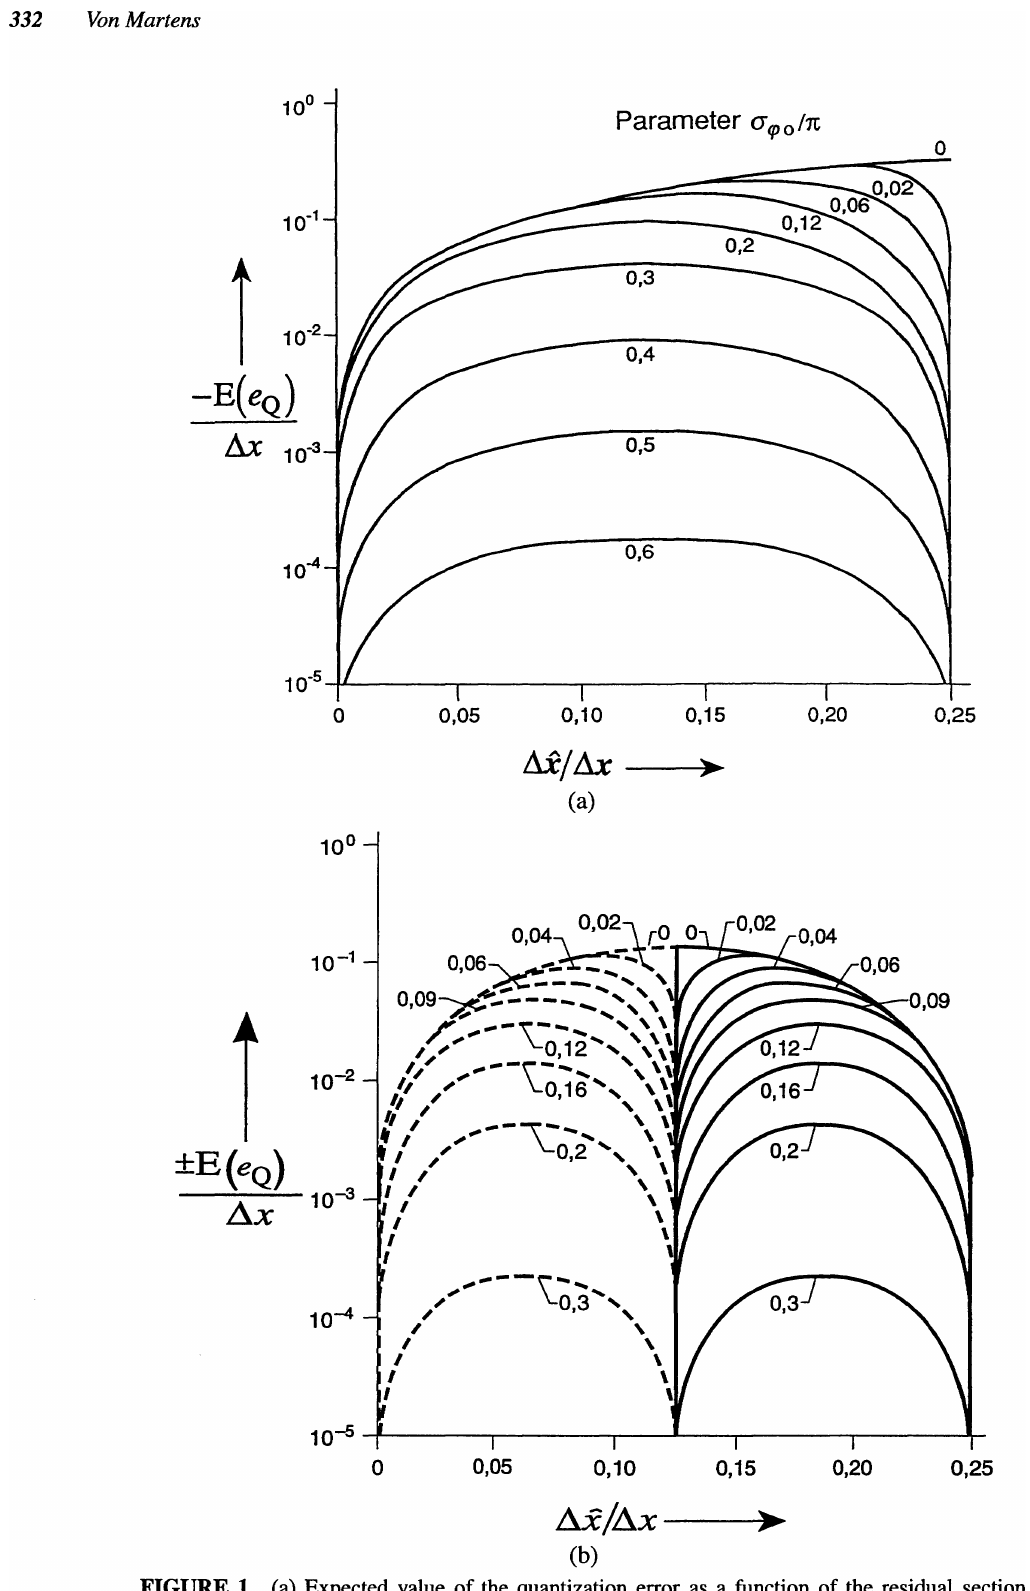
FIGURE 1 (a) Expected value of the quantization error as a function of the residual section 6.x of the deflection amplitude x. 6.x defined by Eq. (12), zero-phase angle stochastic process of 2nd order with: resonance rise Q = 10, expected value E( ((JO) = 0 + J1-7r, J1- = 0, ±l, ±2, ... , standard deviationO"q>o. (b) The same but with expected valueE«({Jo) = 7r/4+